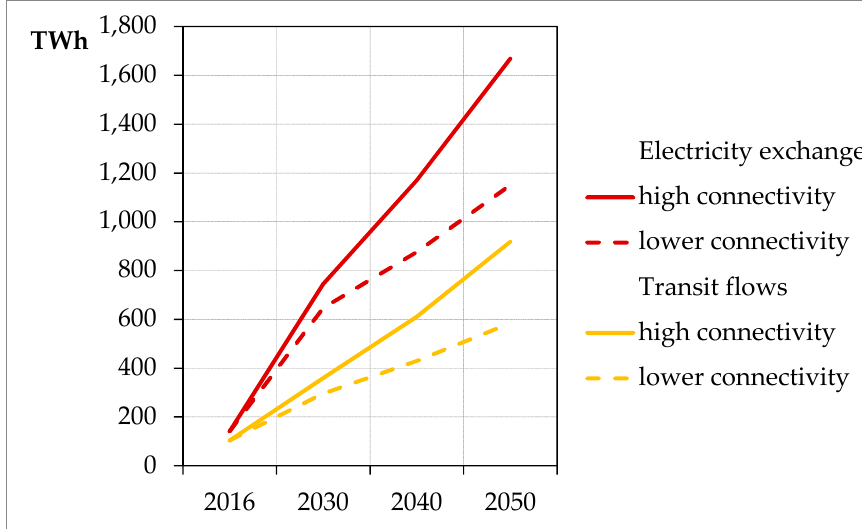
Figure 8. Electricity exchange and transit flows.